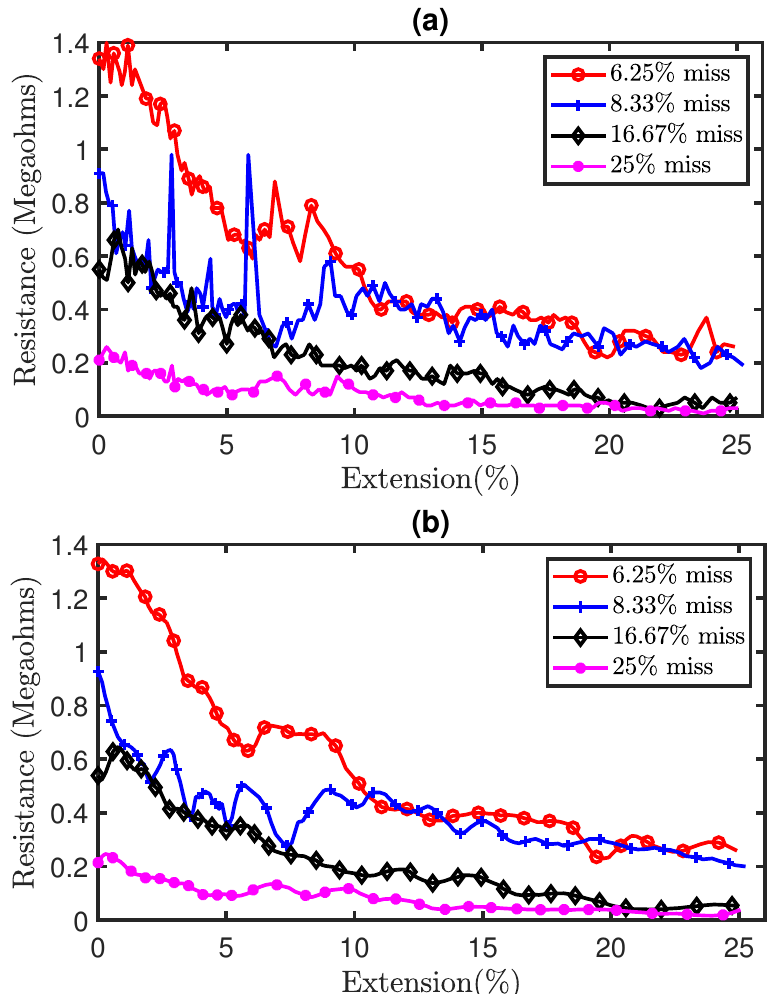
Figure 13. Experimental results of tensile test on sensors with miss stitches. ( a ) Pre-filtered results, ( b ) Post-filtered